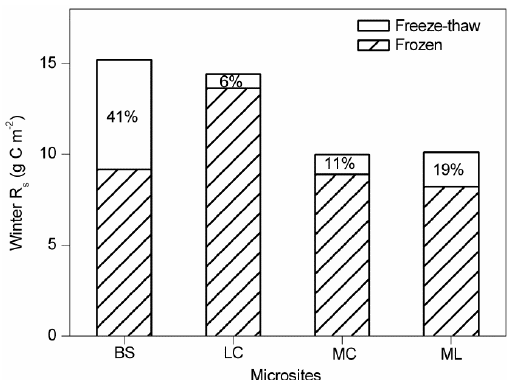
a Letters (m and n) within a column represent significant difference between parameters (significance level α = 0.05) .